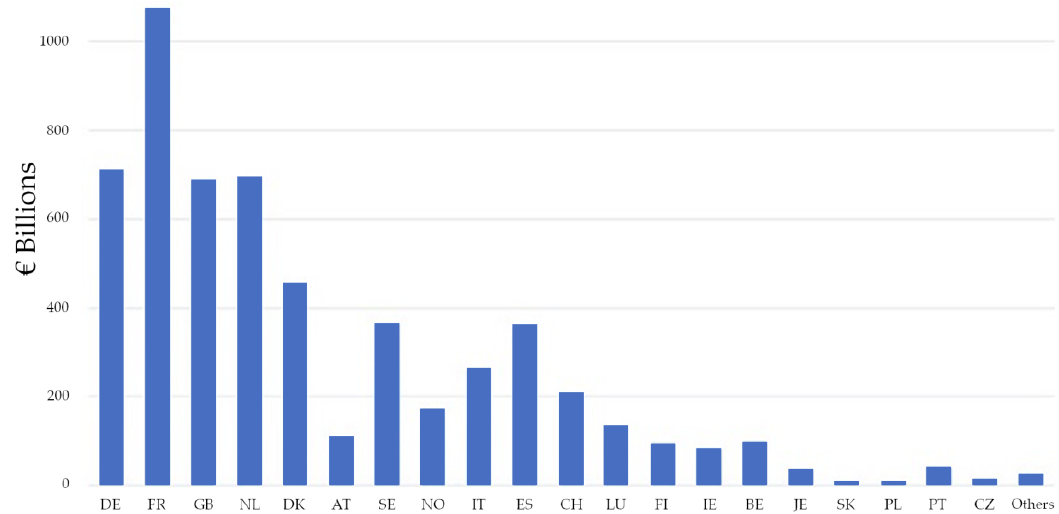
Figure 1. European investment grade corporate bond market by issuer country of incorporation (EUR equivalent). Source: (International Capital Market Association 2020).